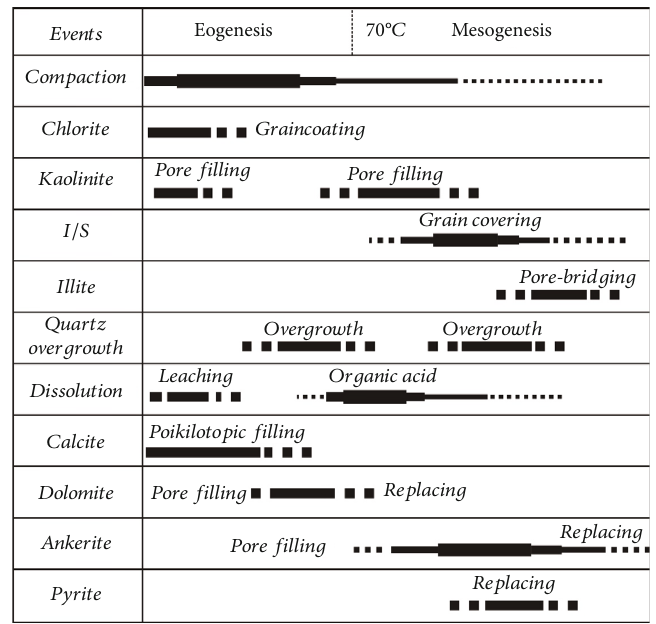
Figure 13: General paragenetic sequences of the Es